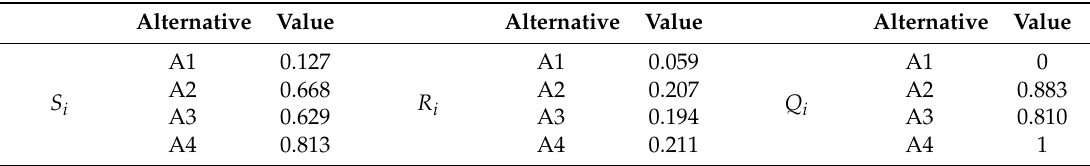
Table 6. Values of S i , R i , and Q i of each